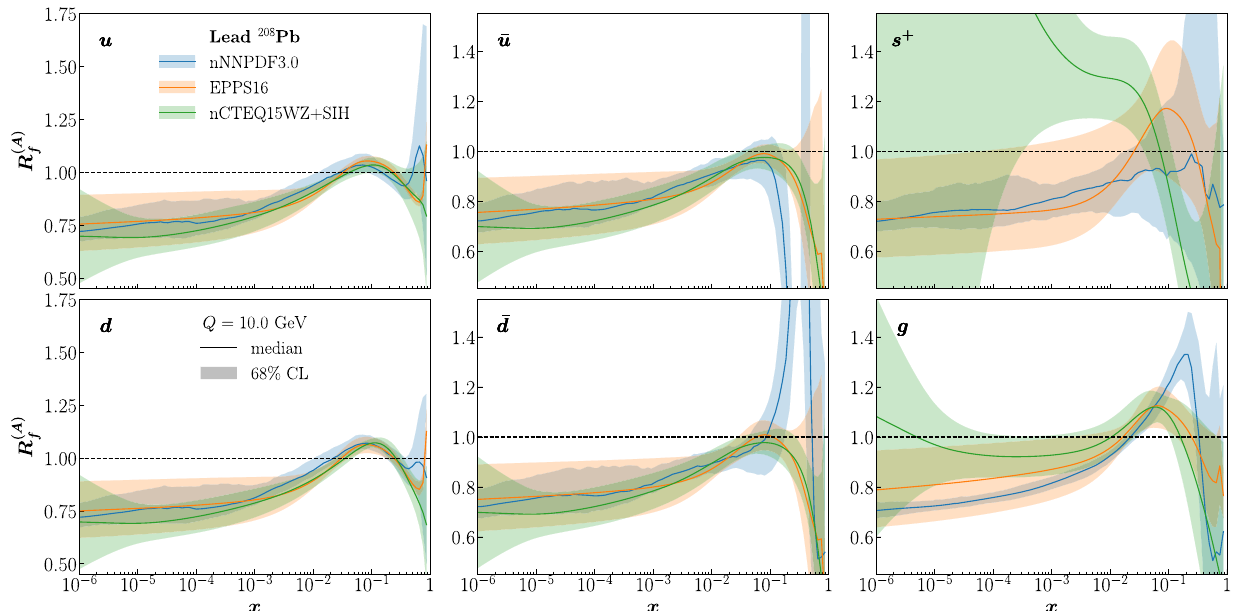
Fig. 17 The nNNPDF3.0 predictions for the nuclear modification ratios in lead at Q = 10 GeV, compared to the corresponding results from the EPPS16 and nCTEQWZ+SIH global analyses. The PDF uncertainty bands correspond in all cases to 68% CL